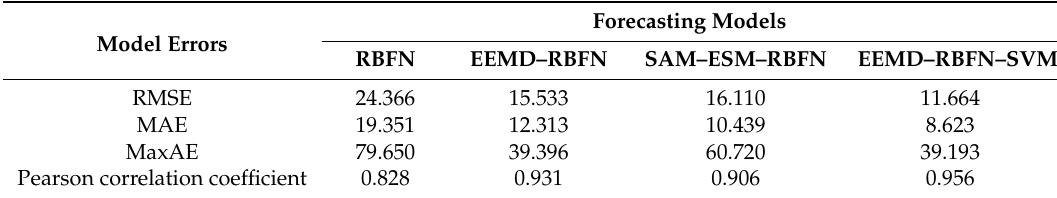
Table 1. Forecasting results by different